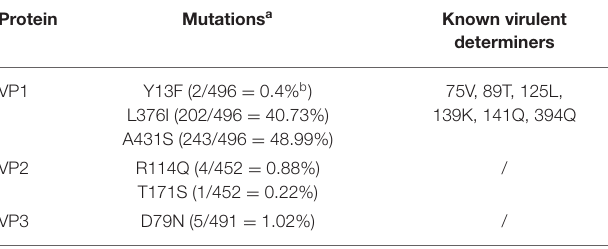
TABLE 2 | Mutations and known virulent determiners in Pigeon-CIAV-1906. Protein Mutations a Known virulent